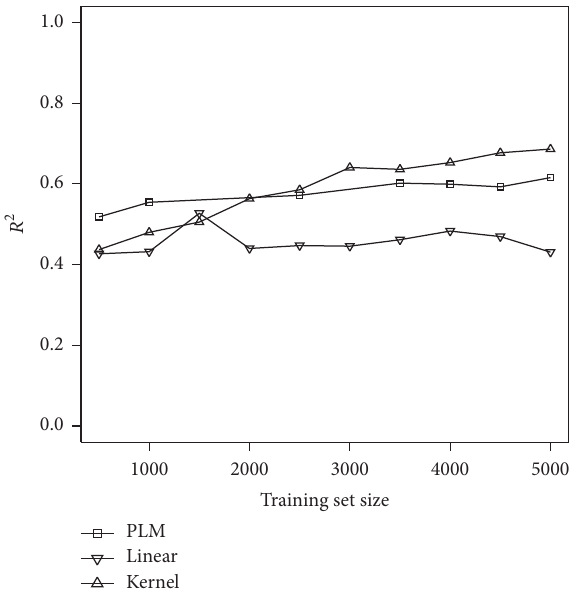
Figure7:Executiontimedependenceontrainingsetsizeforairlines